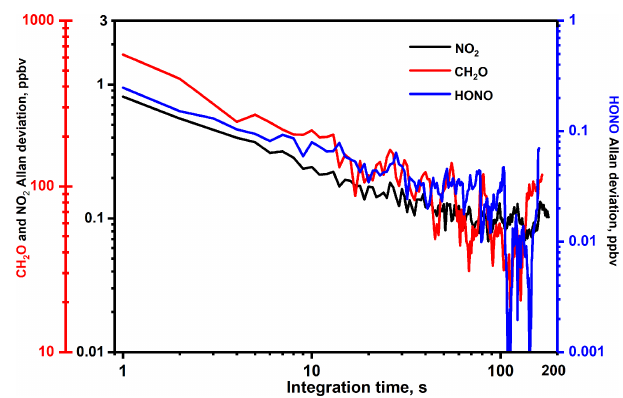
Figure 5. Allan deviation analysis for UV-LED-IBBCEAS perfor- mance